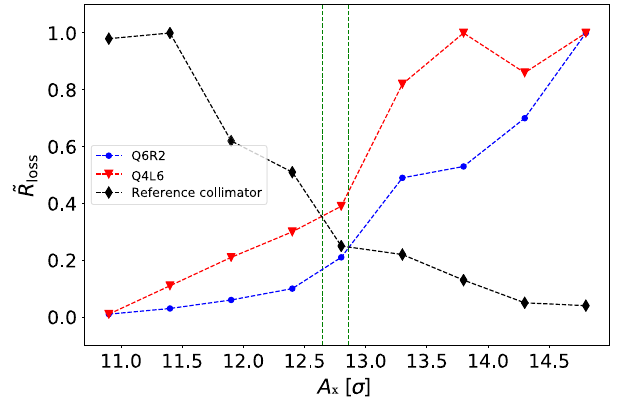
FIG. 5. Normalized losses at the reference collimator (black) and at the magnets Q6R2 (blue) and Q4R6 (red) as a function of the reference collimator half-gap, A x , from aperture measure- ments performed with an ac dipole in 2017 at the LHC injection energy of 450 GeV. The measured aperture value of the bottle- necks corresponds to 12 . 7 σ for Q4L6 and 12 . 9 σ for Q6R2. Adapted under CC BY 4.0 license from [40].